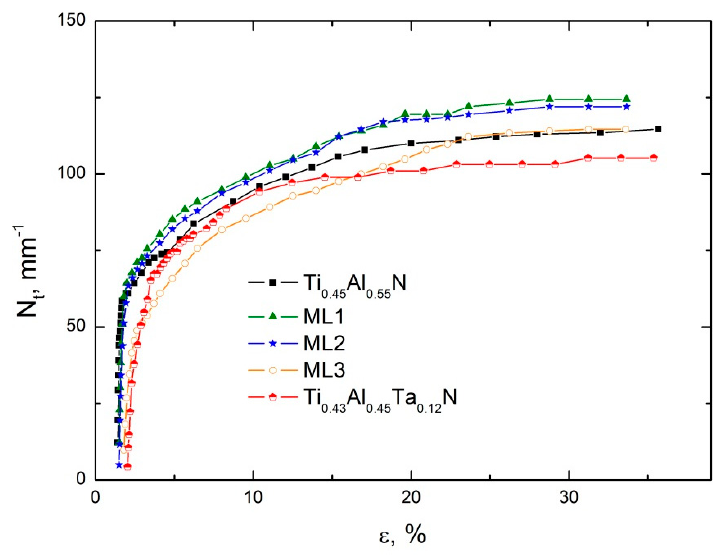
Figure 4. Density of transverse cracks in the coatings subjected to uniaxial tension as a function of substrate elongation.